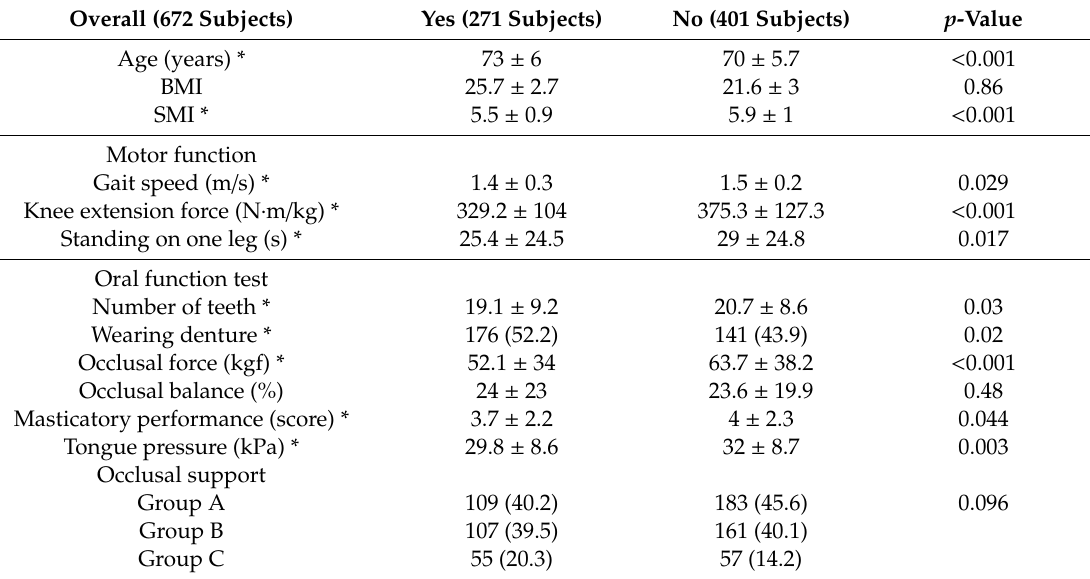
Table 4. The relationship between anxiety over falling, motor function, and oral function. Overall (672